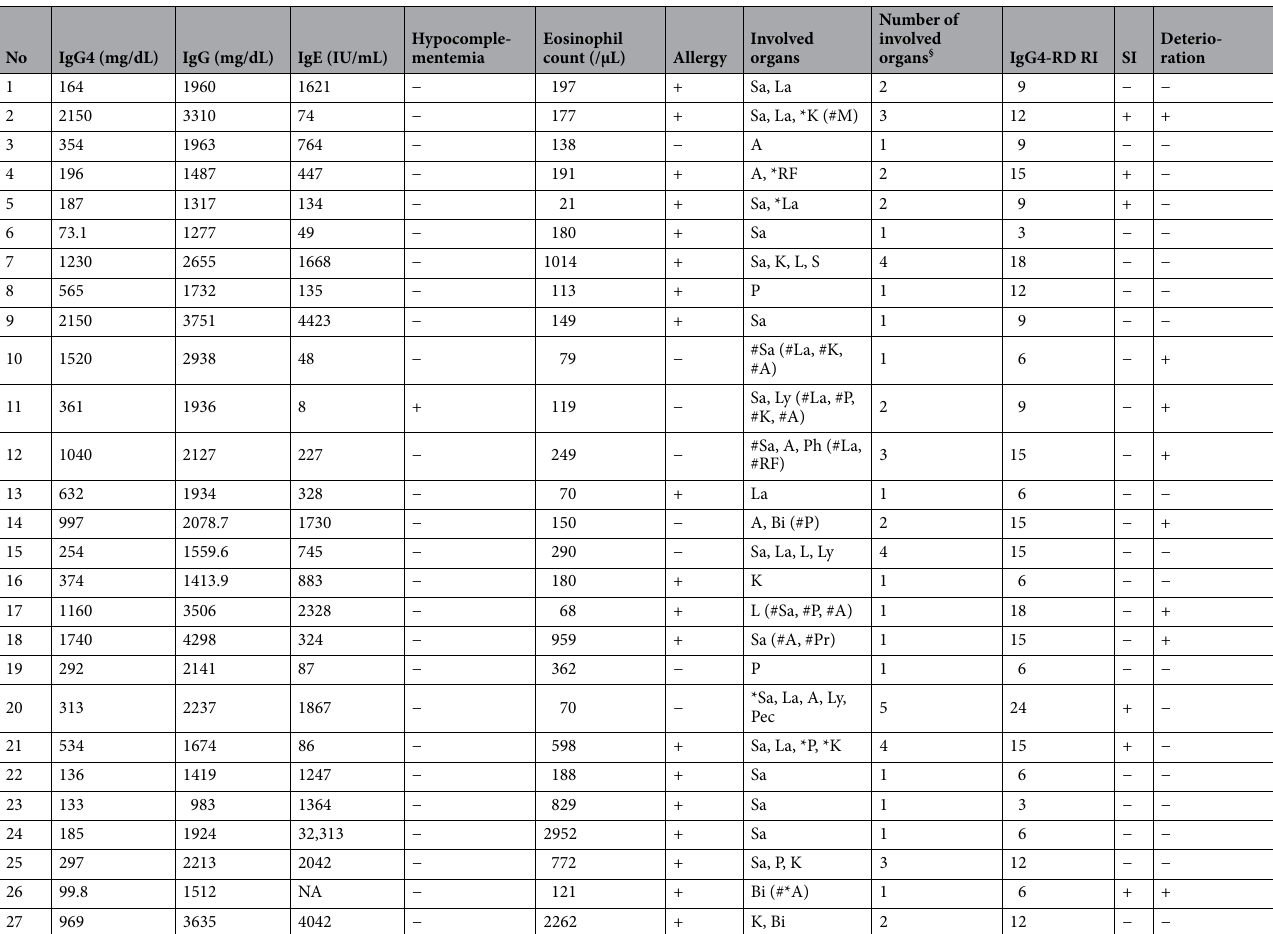
Table 2. Baseline clinical data of 27 untreated patients with IgG4-related disease. A aortic/arterial lesion, Bi bile duct lesion, IgG serum immunoglobulin G levels, IgG4 serum immunoglobulin G4 levels, IgG4-RD